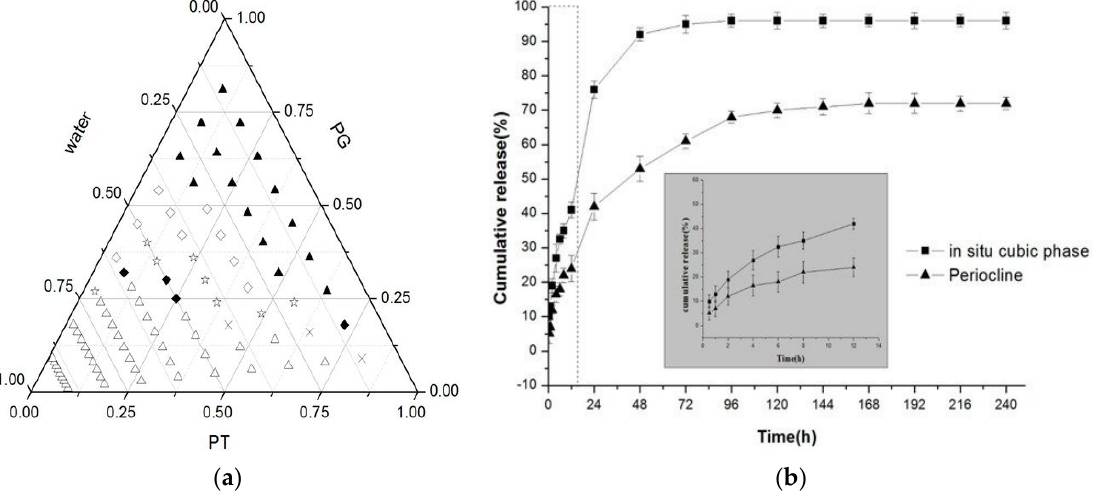
Figure 4. ( a ) Phase behavior of the PHYT-PG-water system. ▲ Isotropic solution; ♢ emulsion; ☆ emulsion + lamellar phase; ♦ lamellar phase; × lamellar + cubic phase; ∆ cubic phase. ( b ) Drug release studies of minocycline hydrochloride-loaded in situ cubic liquid crystal and Periocline ® . Adapted by Yang et al. [128]. Table 1. Summary of the reported case studies, regarding the applications of non-lamellar LLCN as drug delivery nanosystems.